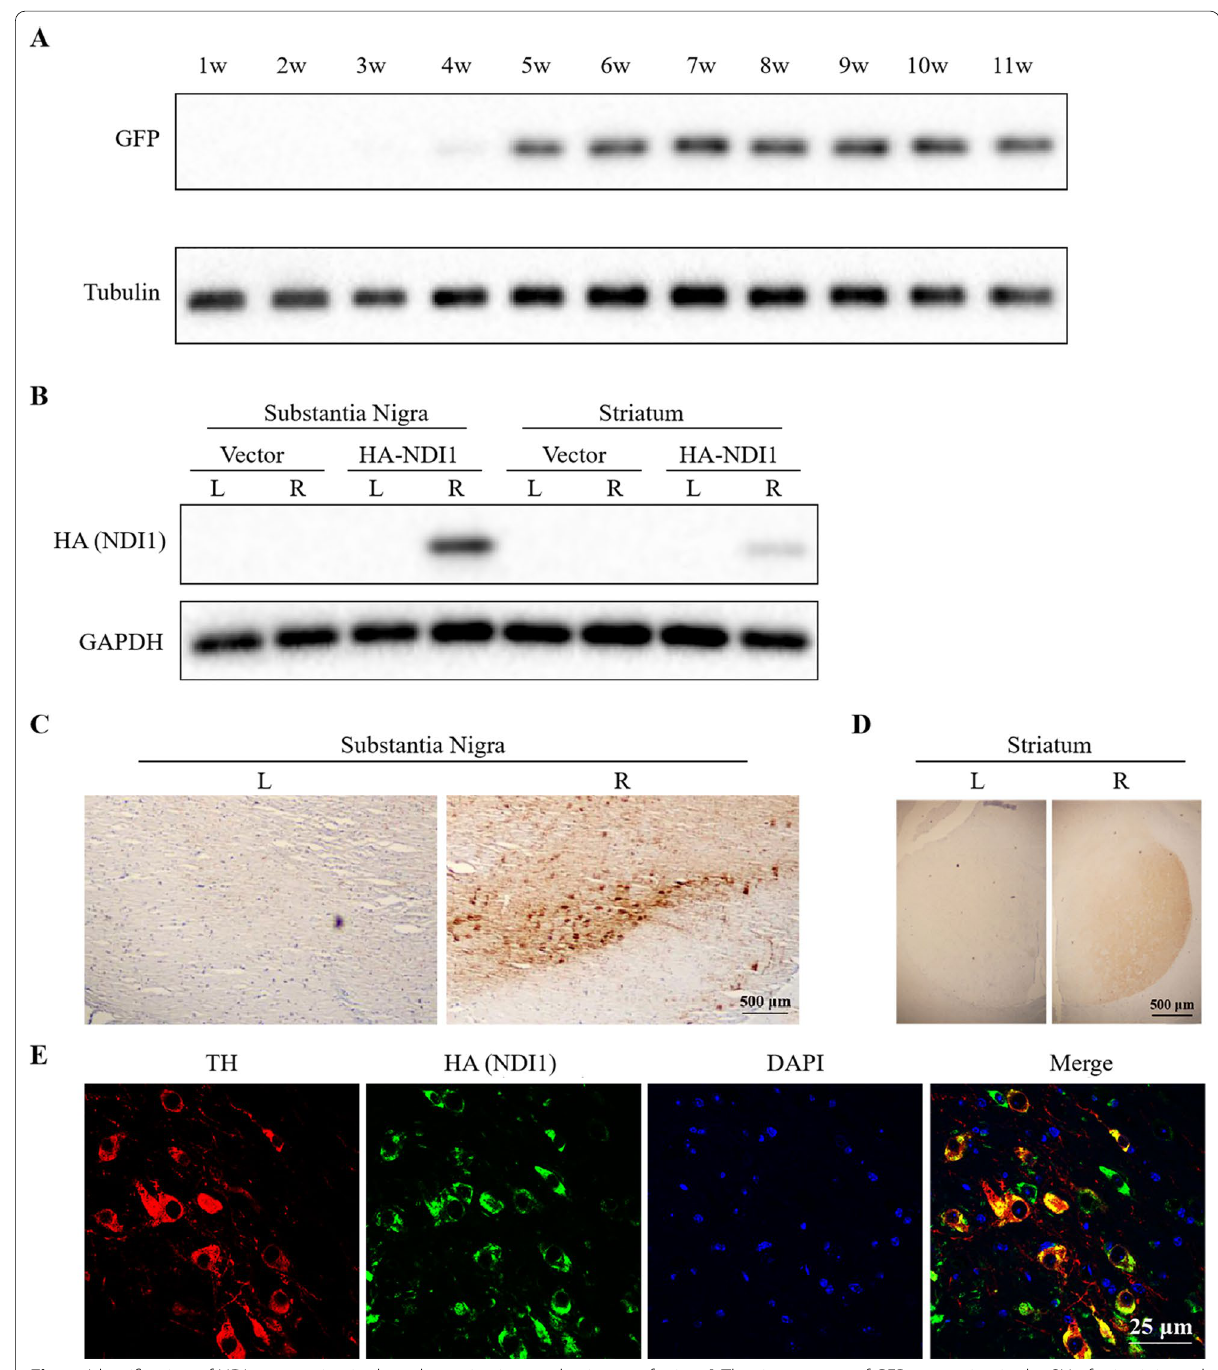
Fig. 5 Identification of NDI1 expression in the substantia nigra and striatum of mice. A The time course of GFP expression in the SN of mice injected with AAV5-GFP was examined by western blot using GFP antibody with tubulin as loading control. W: week. B HA (NDI1) expression in the SN and striatum of mice injected with AAV5-HA-NDI1 was examined by western blot using HA antibody with GAPDH as loading control. L: left; R: right. C , D HA (NDI) expression in the SNpc or striatum of mice injected with AAV5-HA-NDI1 was examined by HA immunohistochemistry. Scale bar E TH (tyrosine hydroxylase) and HA (NDI1) co-localization in dopaminergic neurons of SNpc was examined by a confocal microscopy. SNpc tissue section was co-stained with TH antibody (red, dopaminergic neurons) and HA antibody (green, HA), and counterstained with DAPI (blue, nucleus). Scale bar 25 =